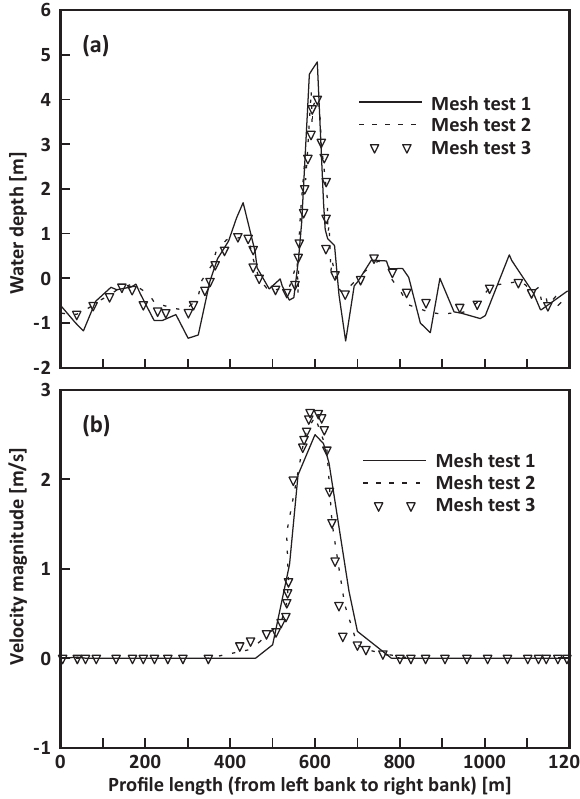
Figure 3. Results of mesh dependence